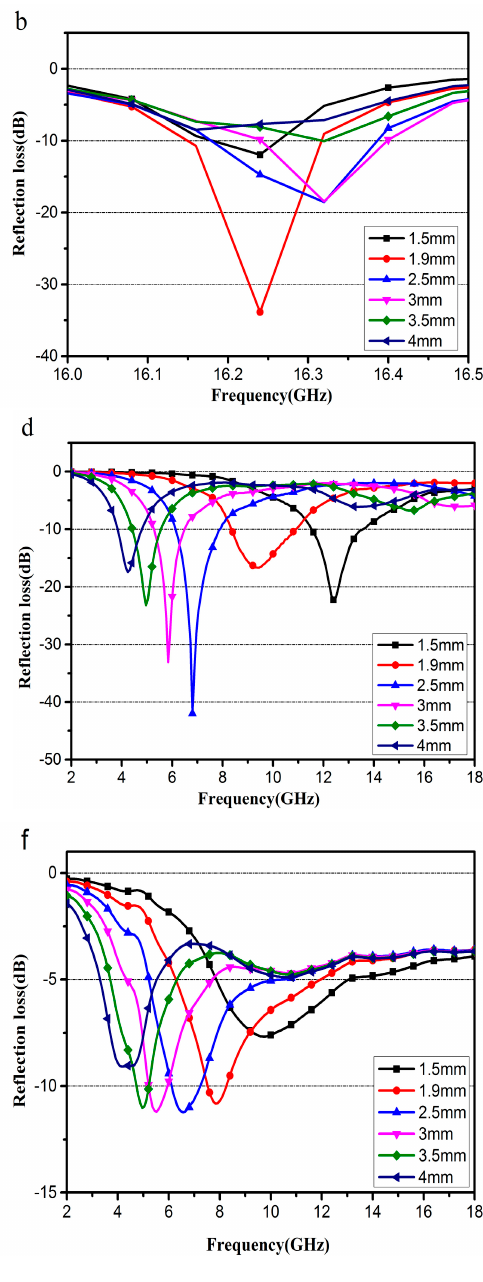
Figure 10. The calculated R L for S1 ( a , b ), S2 ( c ), S3 ( d ), S4 ( e ) and S5 ( f ) with different thicknesses in the frequency range of 2–18 GHz.